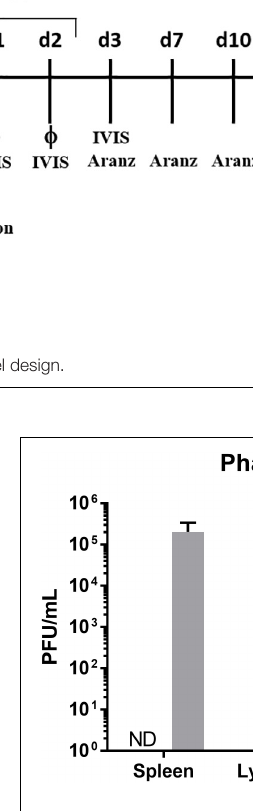
FIGURE 2 | Distribution of phage upon administration. Naïve Balb/c mice were assessed for phage titers 24 h after PBS or phage mixture administration. N = 7 per group (ND = not